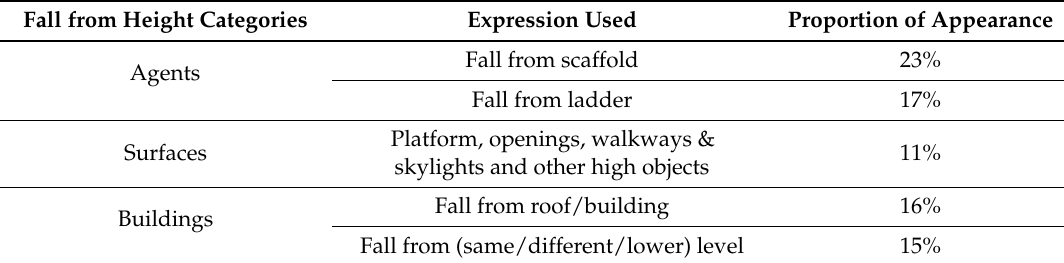
Table 8. FFH categories.